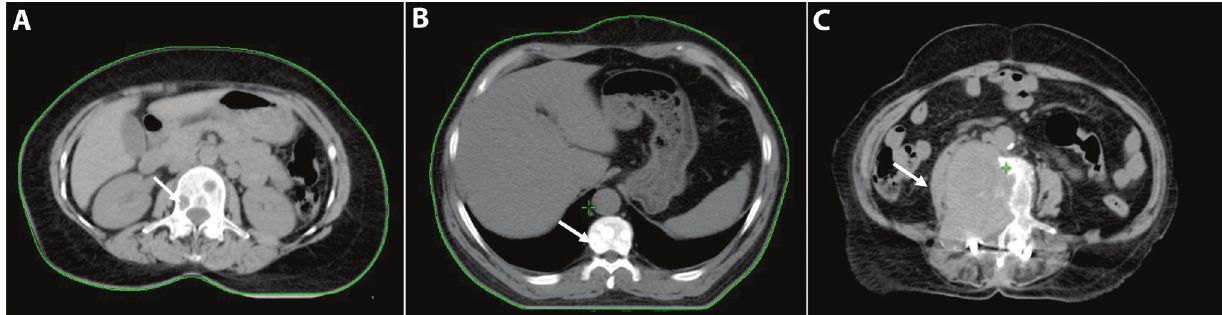
Figure 1 - Types of bone metastasis (white arrows) . A) Osteolytic metastasis. B) Osteoblastic metastasis. C) Bone metastasis with a tumor